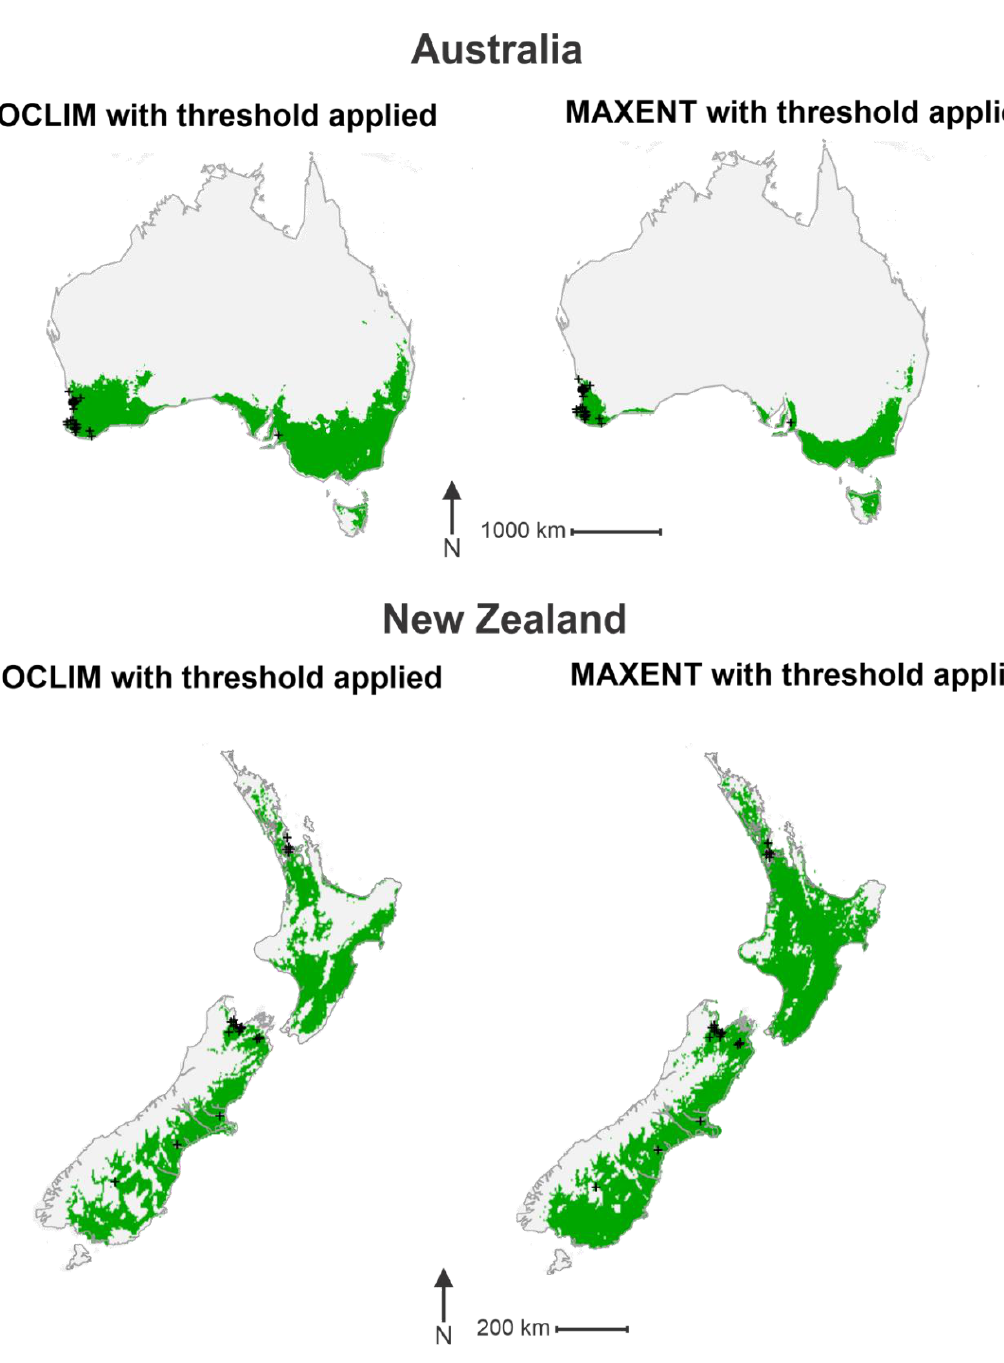
Figure 3. Predicted presence/absence plots for each region based on the two model outputs. For both models, thresholds (0.005 and 0.38, respectively) are calculated as the raw output value at which the sum of the true positive and true negative rates is maximized. Locations where the raw output values are over these thresholds are denoted a present status (1) and highlighted in green. Locations where raw output values are lower than the threshold are denoted an absent status (0) and remain grey. Black crosses indicate known occurrences of P. dominula .